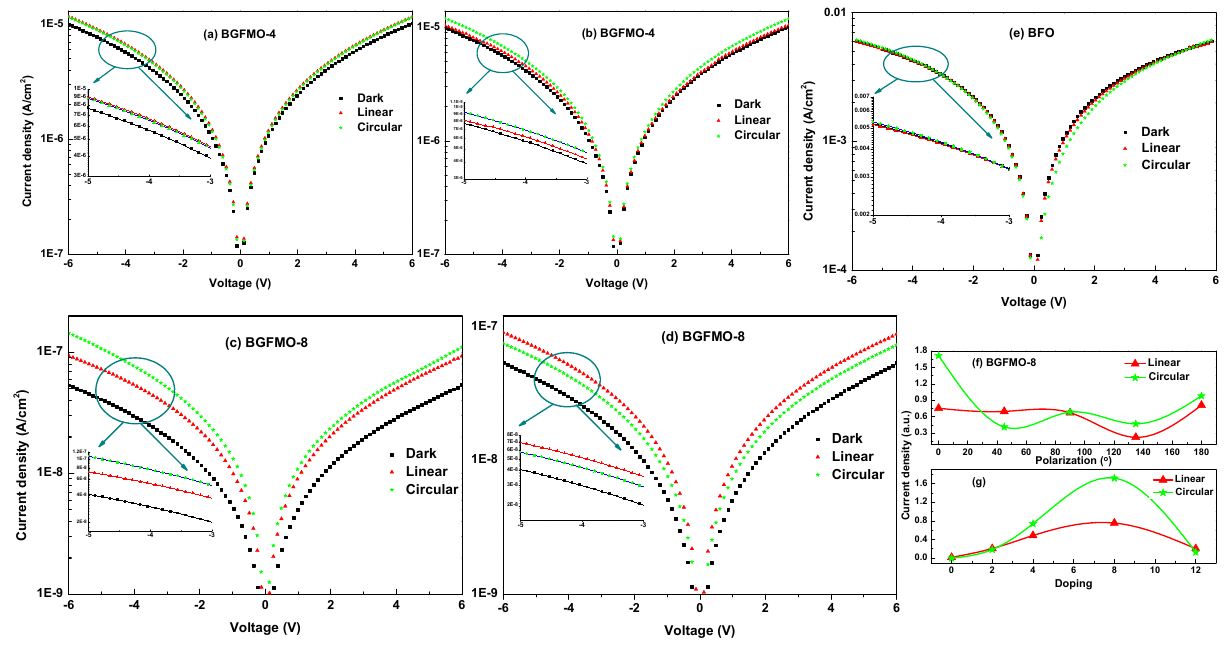
Figure 3. ( a – e ) Leakage I-V curves measured at room temperature under polarization-modulated commercial 405 nm laser illumination using pure BFO and co-doped films. ( f ) Variation of leakage current as rotation of λ /4 plate based on BGFMO-8. ( g ) The trend of linearly and circularly polarized photo current from BFO, BGFO to